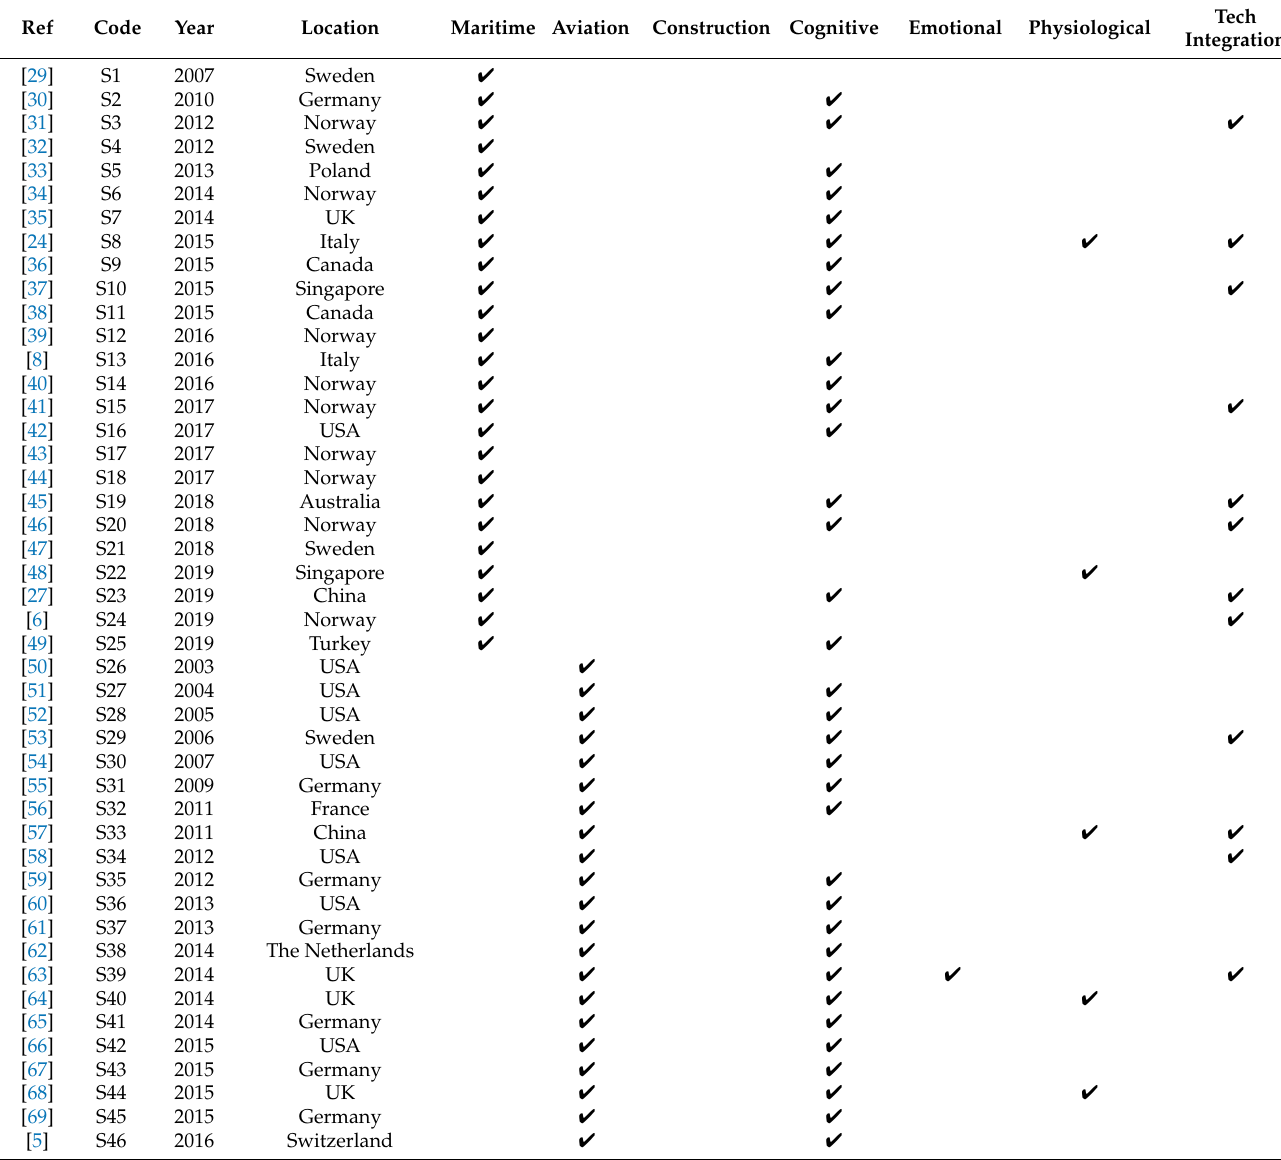
Table 2. Classification of the selected classification of eye tracking